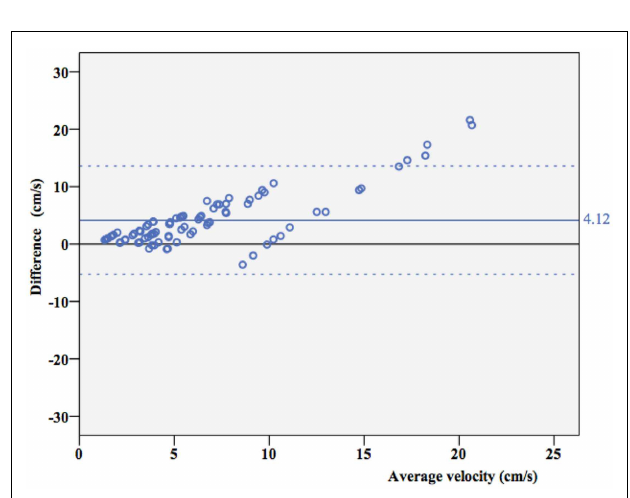
FIGURE 3 | Pump velocity versus measured Doppler velocity . Relation between true velocity (centimeter per second) and velocity measured (centimeter per second) in different settings: (A) with or without steer angle correction, (B) color Doppler versus power Doppler, (C) convex versus linear